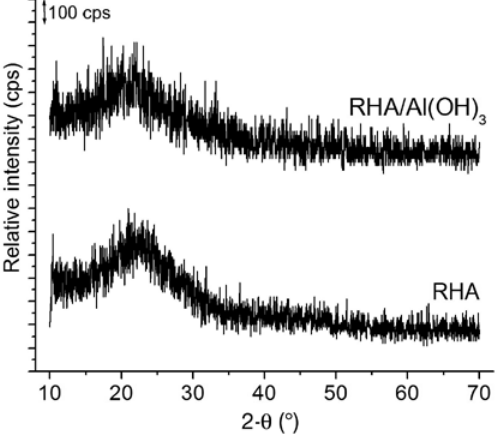
Figure 2: XRD diagrams of rice husk ash and RHA/Al(OH)